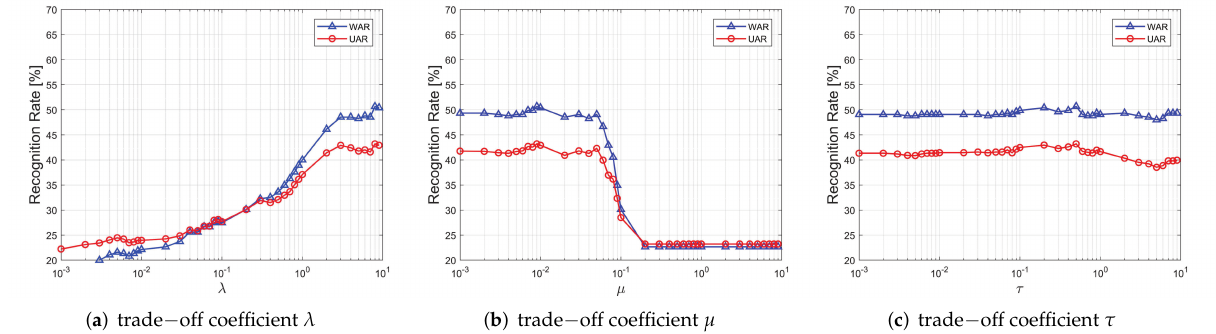
Figure 2. The parameter sensitivity analysis of three trade − off parameters (i.e., λ , µ , τ ) for our proposed JIASL method on the cross-corpus SER task of E →